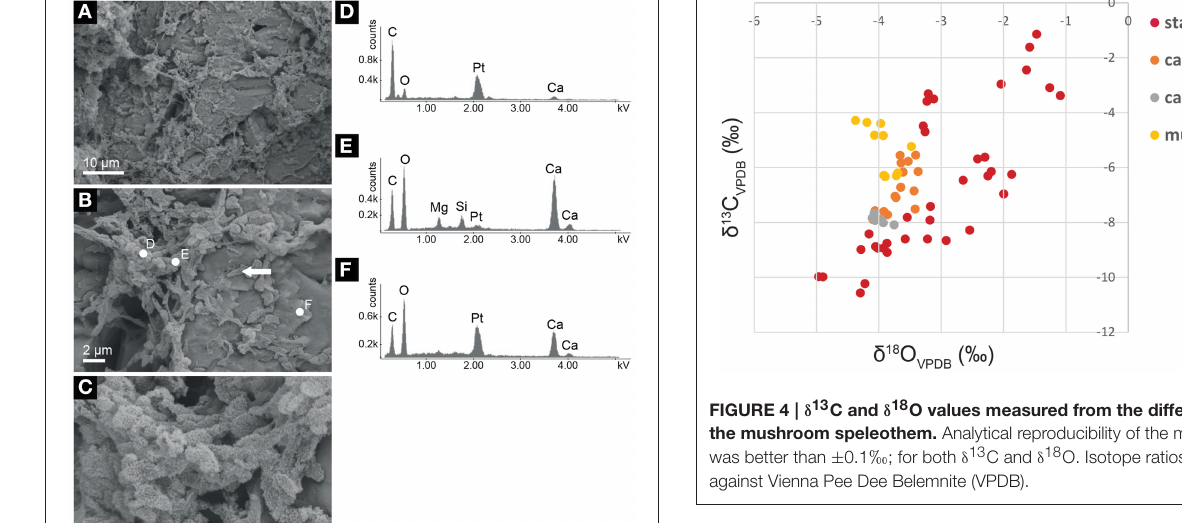
4 distinctive phases, within an evolving cave environment ( Figure 5 ): Phase 1 (Figure 5A): The innermost component of the speleothem is comprised of a common stalagmite. Its mineralogy, petrography and isotopic composition are similar to those measured in other stalagmites forming in tropical environments through dripping water from the cave ceiling (Hill and Forti, 1997; Mickler et al., 2006; Fensterer et al., 2012). During this period the cave was dry, suggesting a colder and drier climate with low sea level. Phase 2 (Figure 5B): The conical deposit, which covers the invaded by water submerging the stalagmite. This